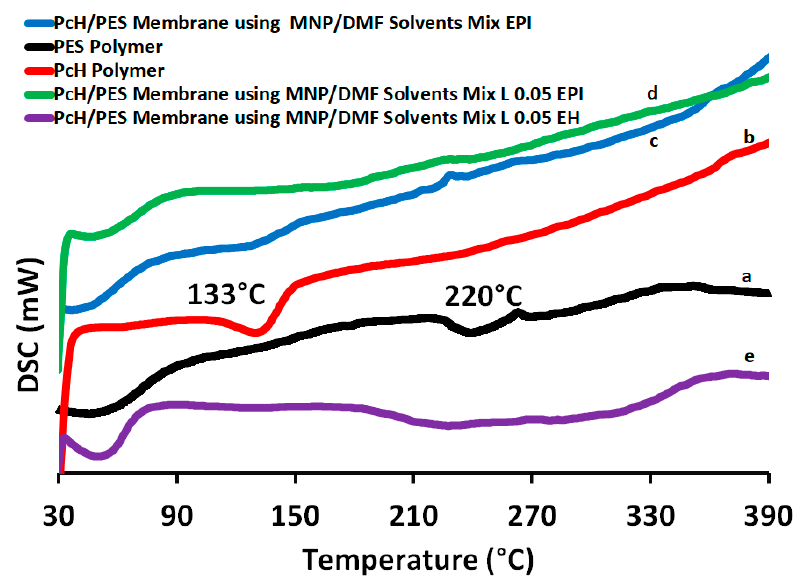
Figure 12. Differential scanning calorimeter (DSC) analysis of PES polymer ( a ), PcH polymer ( b ) PcH/PES blend membrane using a NMP/DMF solvents mix without LiCl post-treated by heating at 60 °C ( c ) and with LiCl post-treated by phase-inversion at 40 °C ( d ) and by heating at 60 °C ( e ).